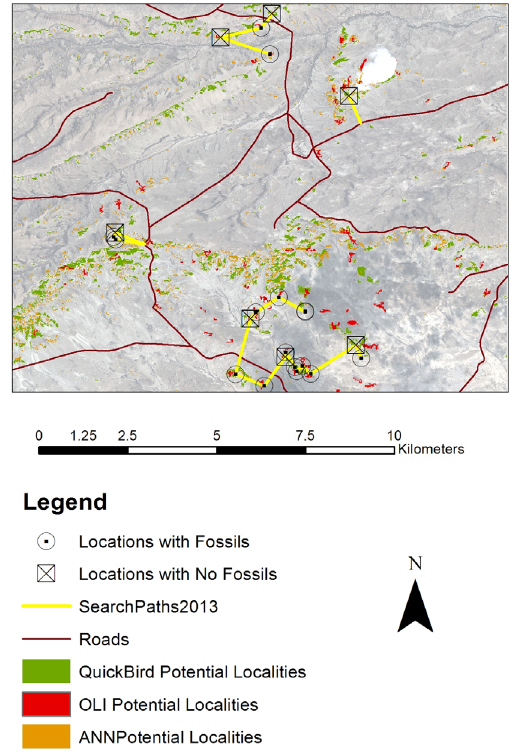
Figure 3. Freighter Gap/Pinnacles QuickBird image showing potentially fossiliferous ANN-, OLI-, and QuickBird-based image objects and selected high priority candidate localities.